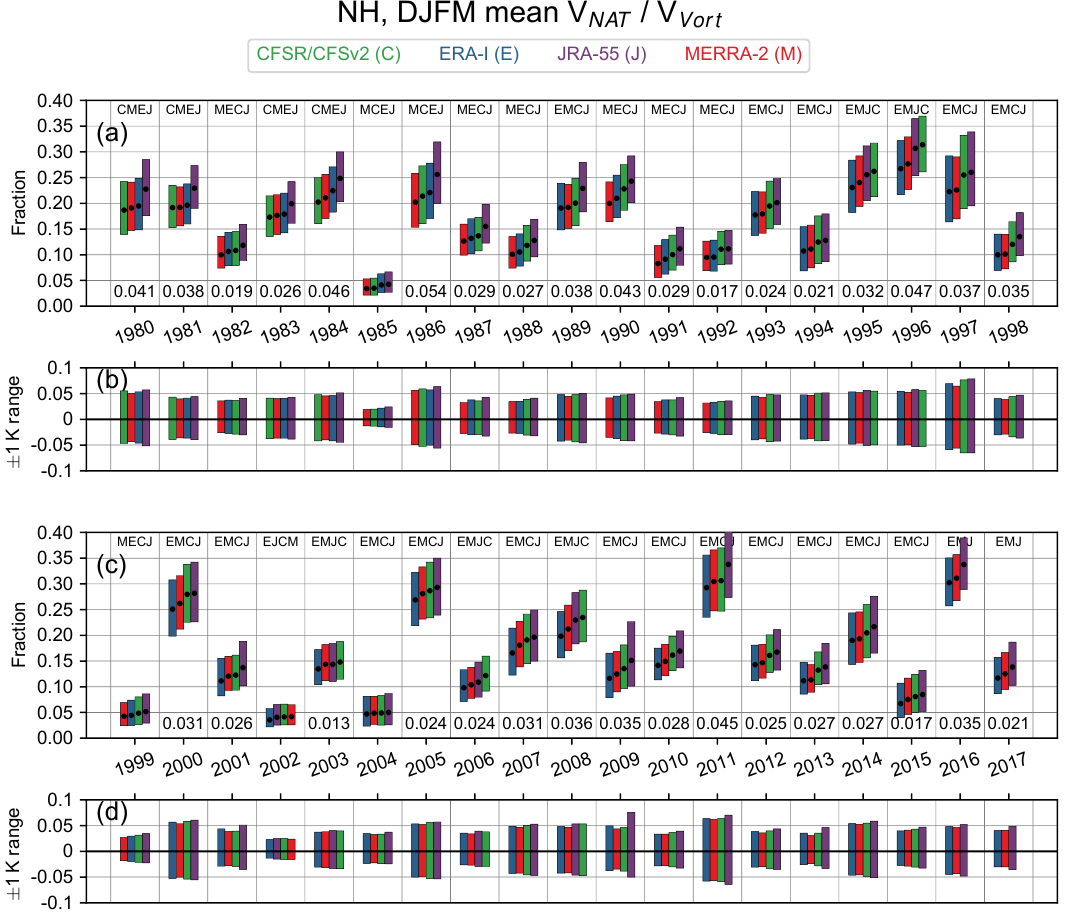
Figure 16. As in Fig. 15 but for the NH and temperatures below T NAT